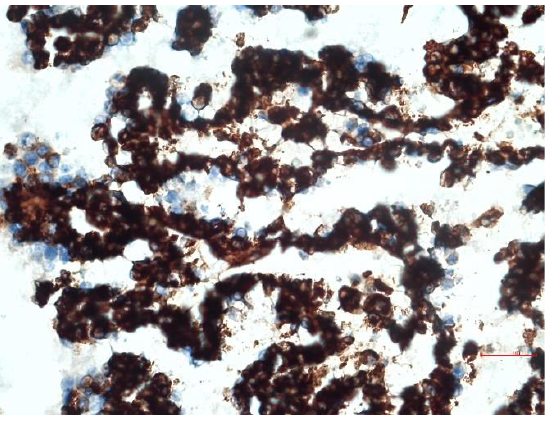
Figure 8. Lung: IHC vimentin: broad positivity of most cancer cells. Bar = 30 µm.